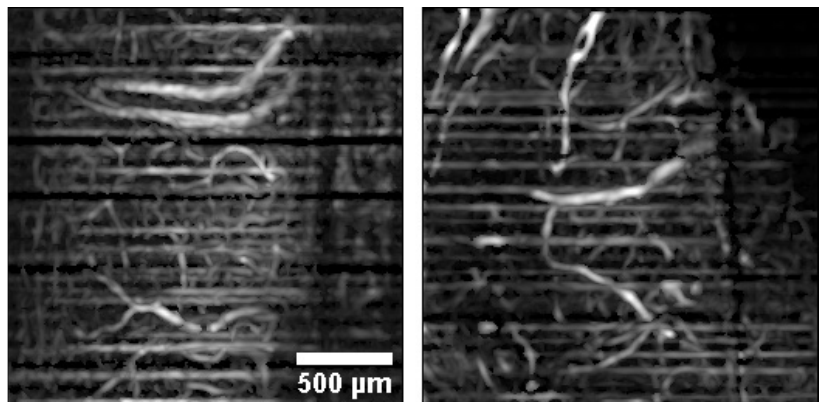
Fig. 13. Maximum intensity projection of super¯cial cortex layer shows dense vessel topography in both cases of control (left panel) and 8 days developed glioma (right